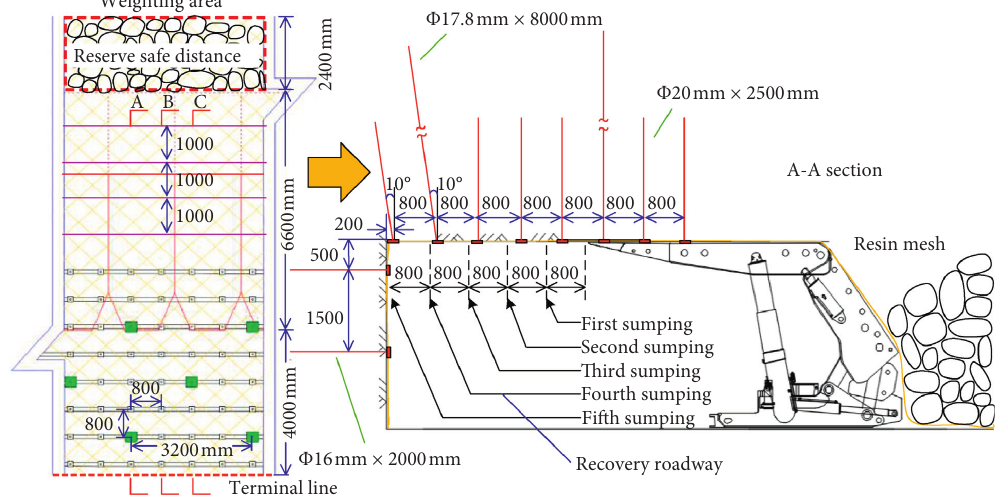
Figure 18: Improved support design of the recovery roadway in the Fengjiata coal